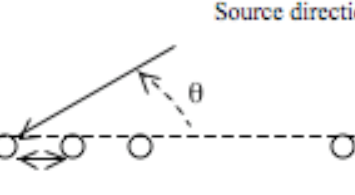
Fig. 1. A linear array of N elements